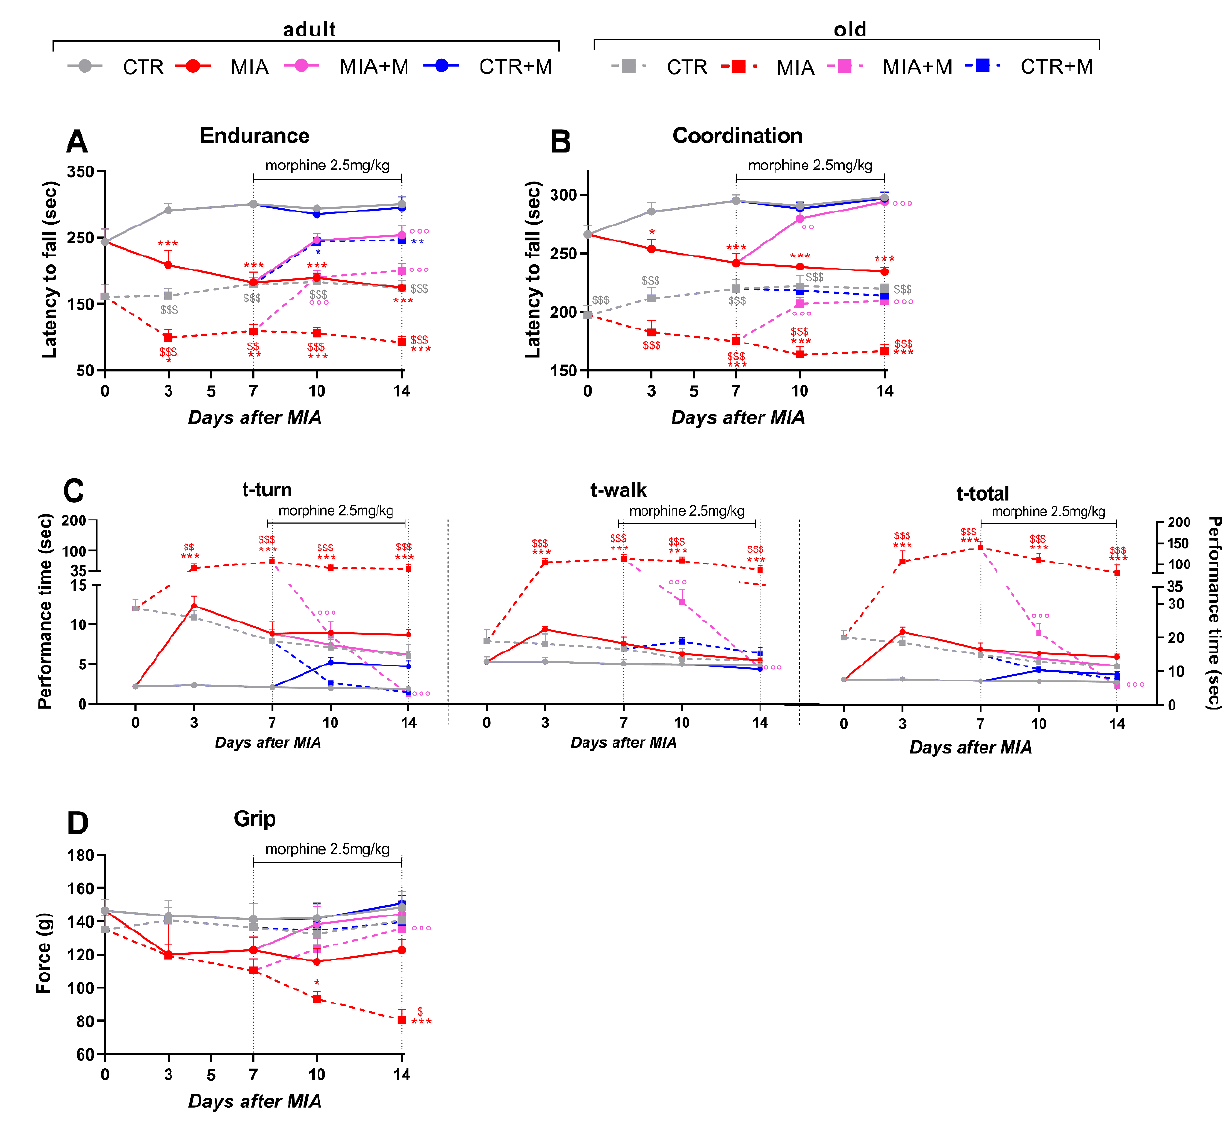
Figure 2. Locomotor activity. Evaluation of locomotor deficits, assessed with rotarod test ( A ), endurance: 10 rpm in 300 s-constant protocol-; ( B ), coordination: 4–20 rpm in 300 s-acceleration protocol-); static rod test ( C ), balance and coordination) and of muscle strength ( D ), assessed